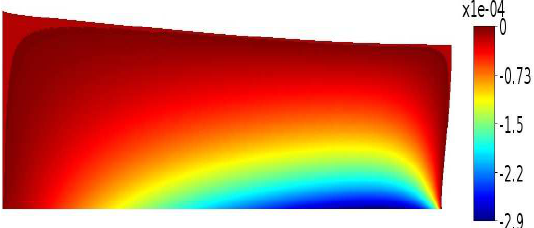
Figure 5. Temperature field in the deformed